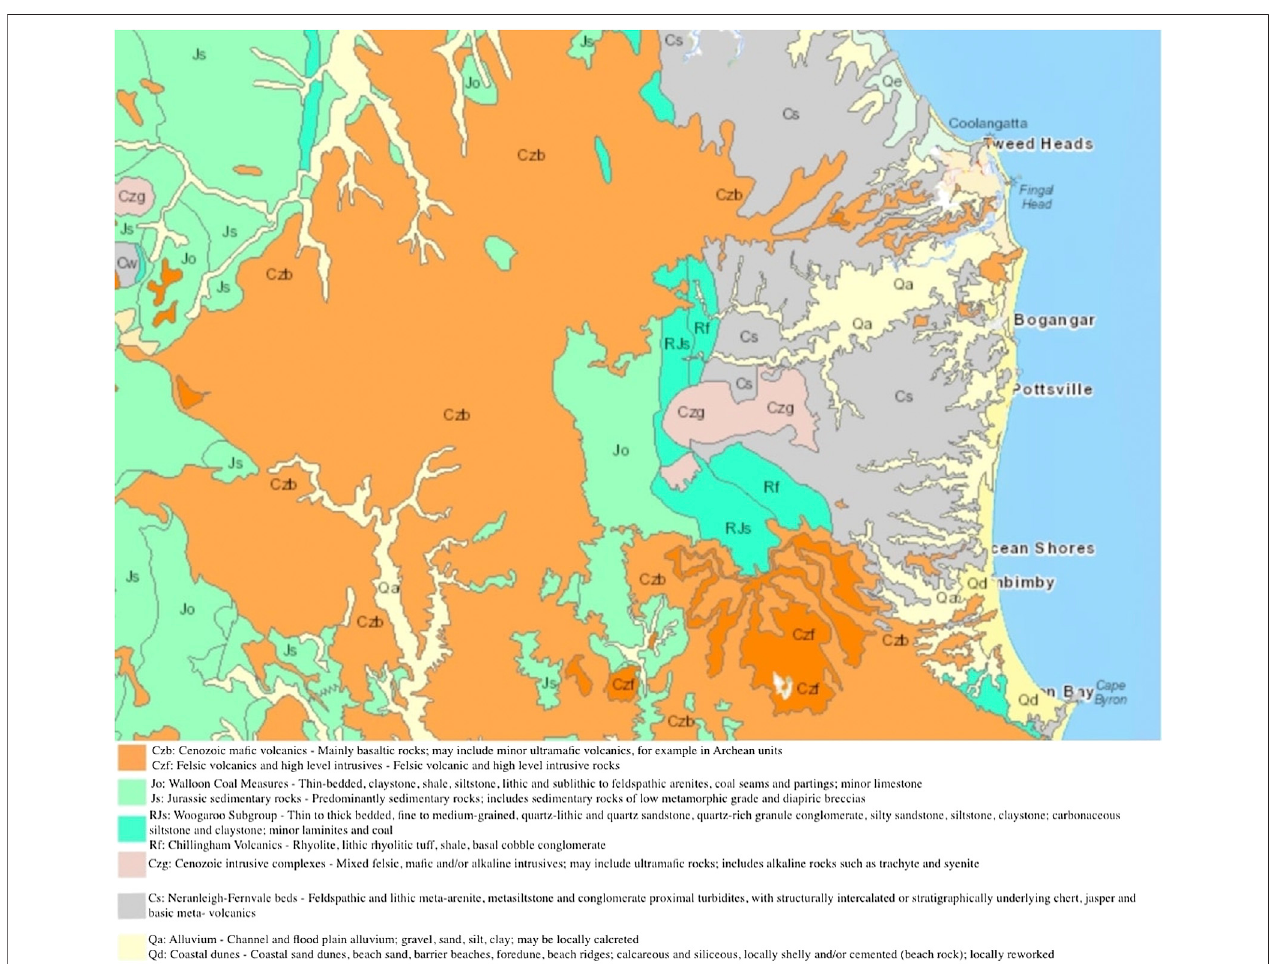
FIGURE 2 | Geologic map of the studied area (Commonwealth of Australia, Geoscience Australia, 2020).